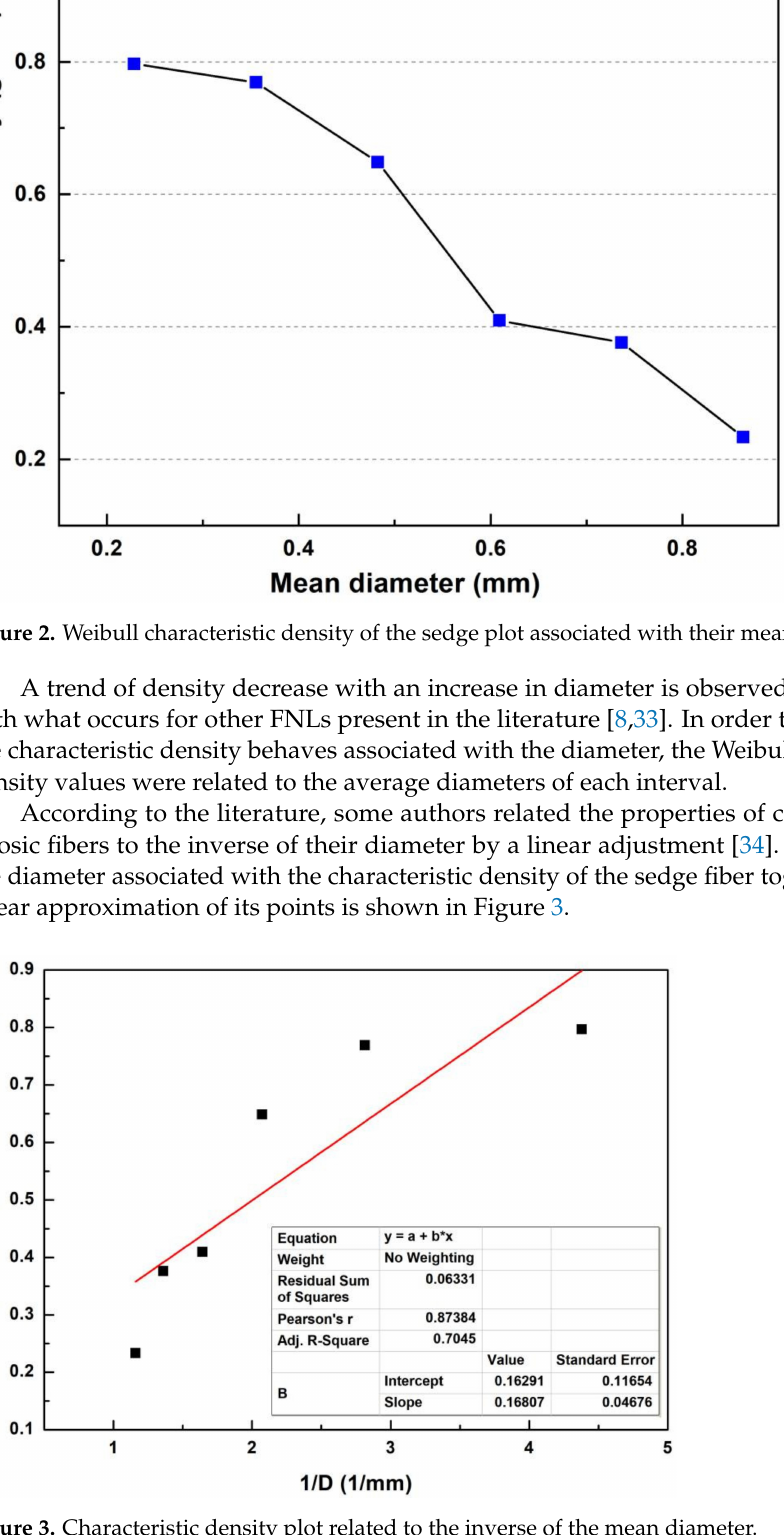
Figure 3. Characteristic density plot related to the inverse of the mean